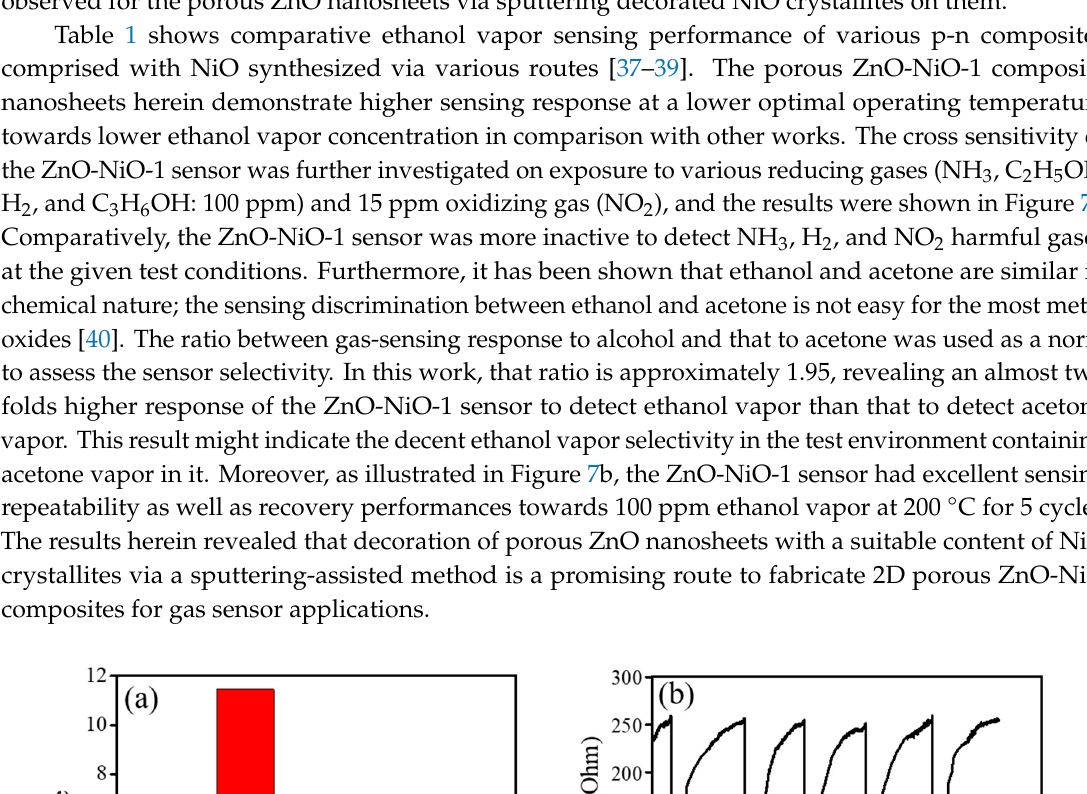
Table 1. Comparative ethanol vapor sensing performance of various p-n composites comprised with NiO synthesized via various synthesis routes [37–39].